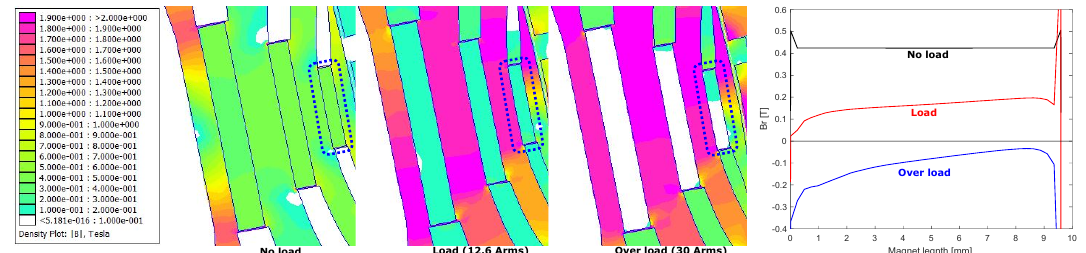
Figure 17. Demagnetization analysis of the Ferrite PMaREL